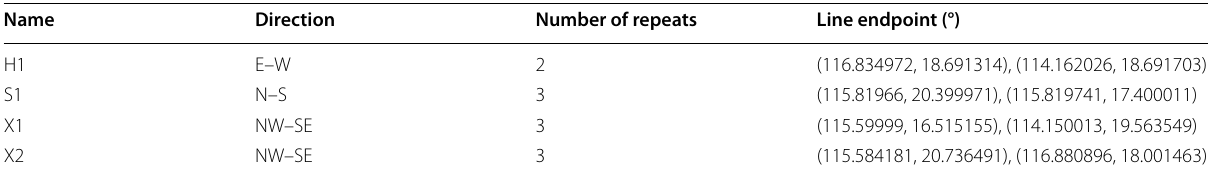
Table 3 Information of the repeated ship lines Name